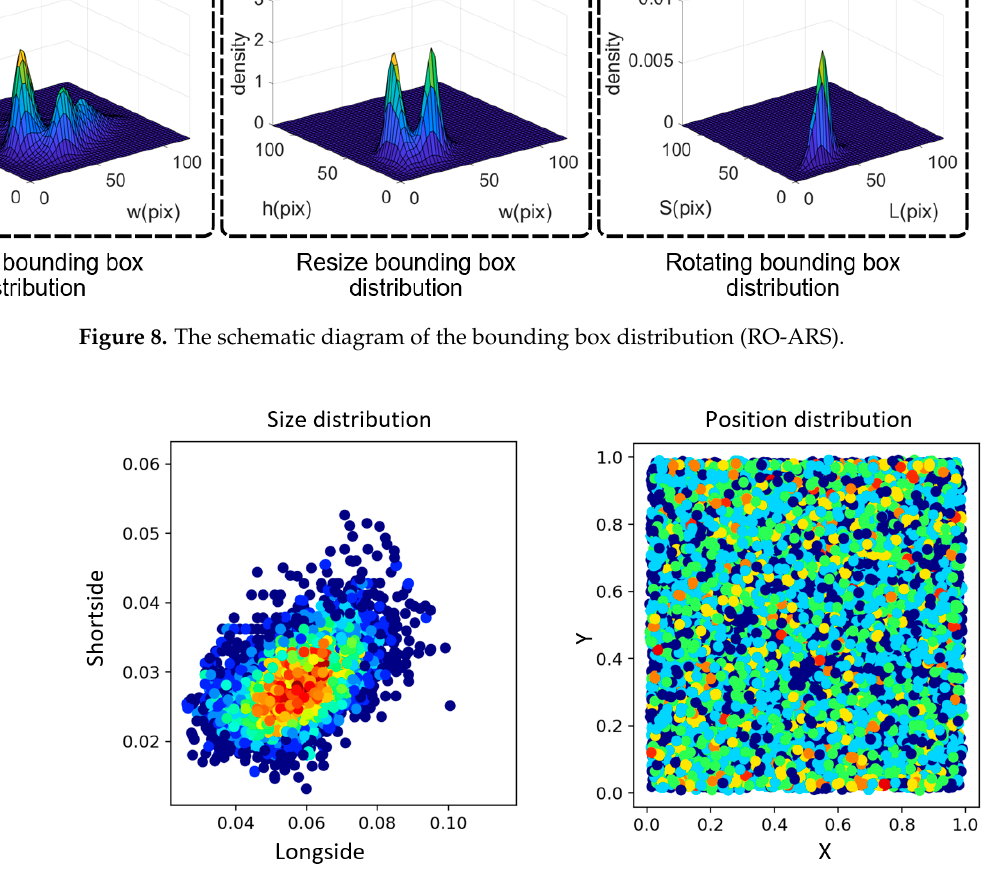
Figure 9. The target size and position distribution (RO-ARS).